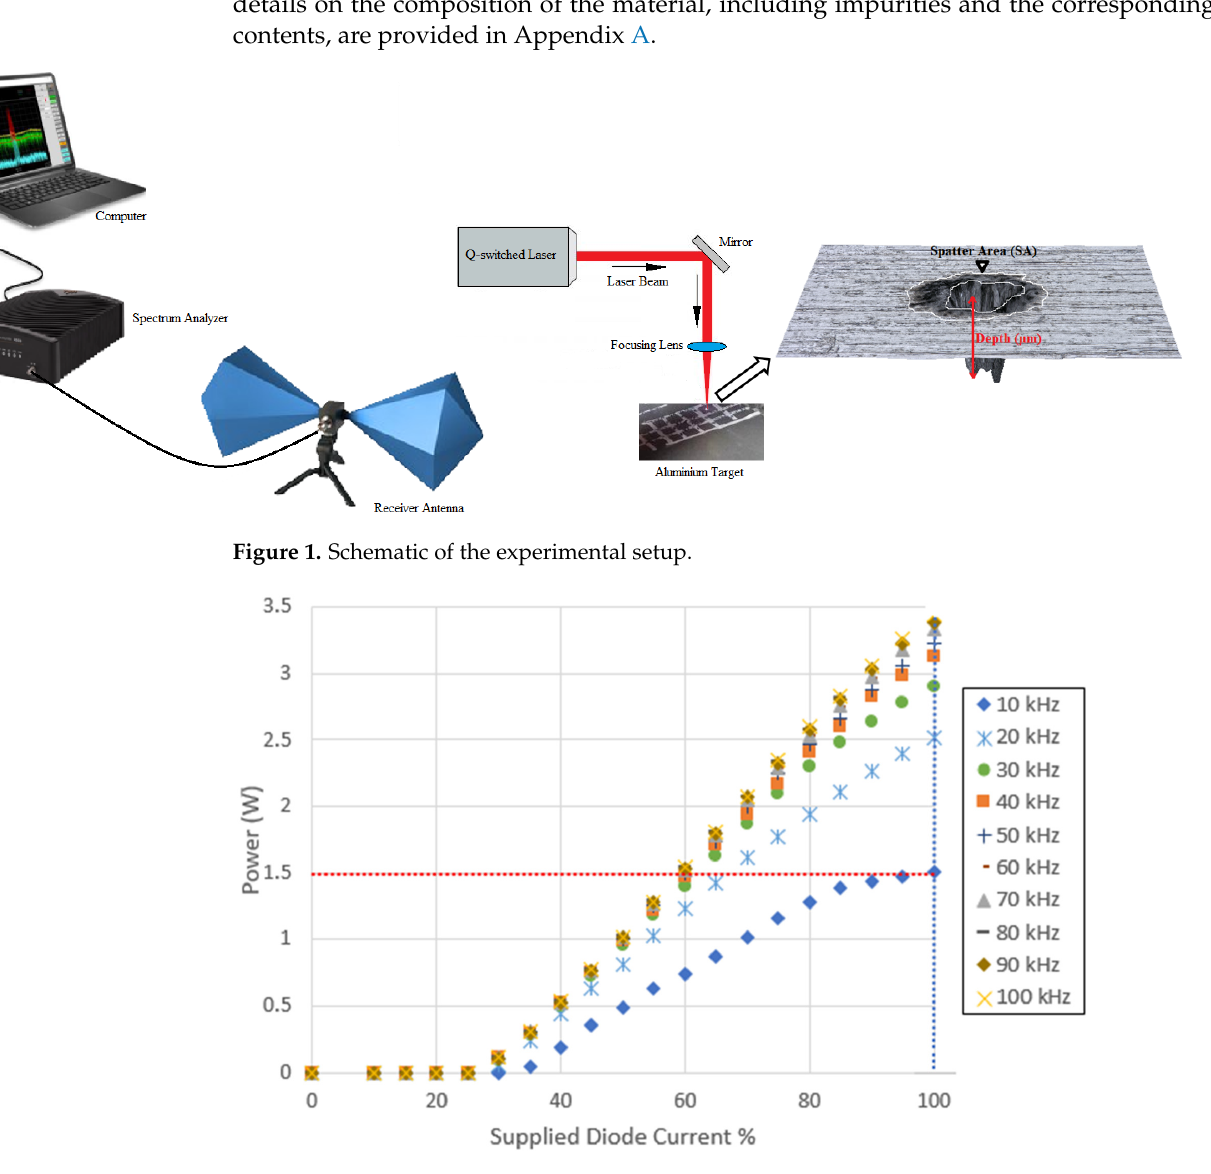
Figure 1. Schematic of the experimental setup.